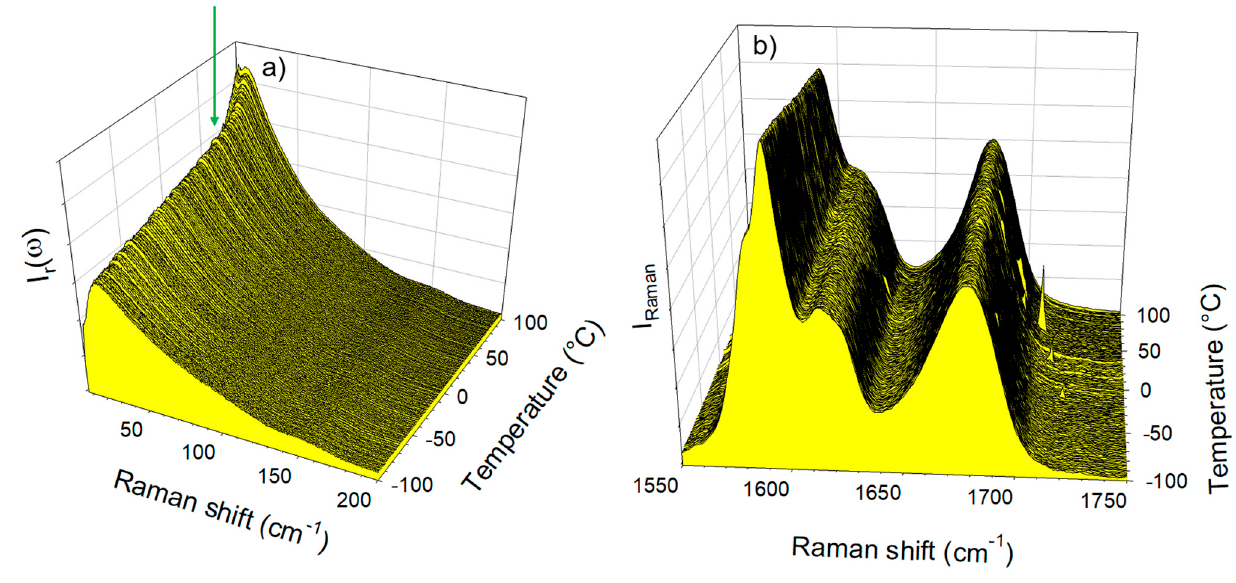
Figure 7. Temperature dependence of the Raman spectrum of the IMC–ARG blend collected upon heating at 1 °C/min ( a ) in the low-frequency region (the arrow indicating the T g ) and ( b ) in the C=O stretching region .